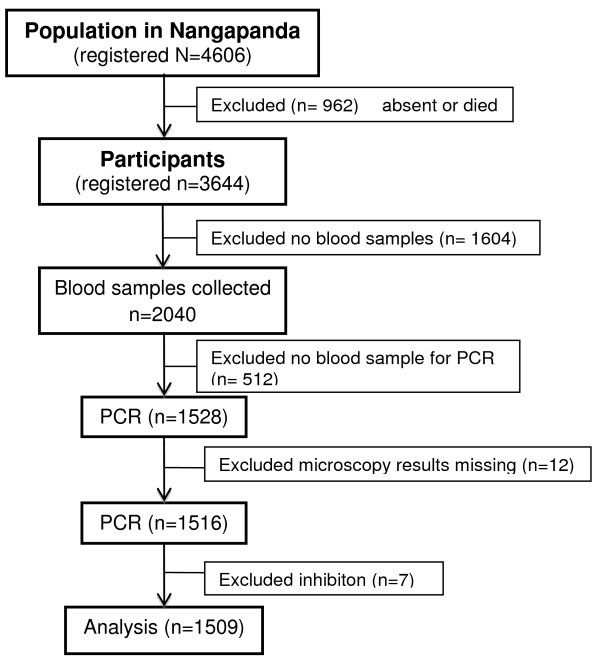
Flow chart: Cases available for describing the epidemiology of Plasmodium infections in Flores Island, Indonesia using real-time PCR.